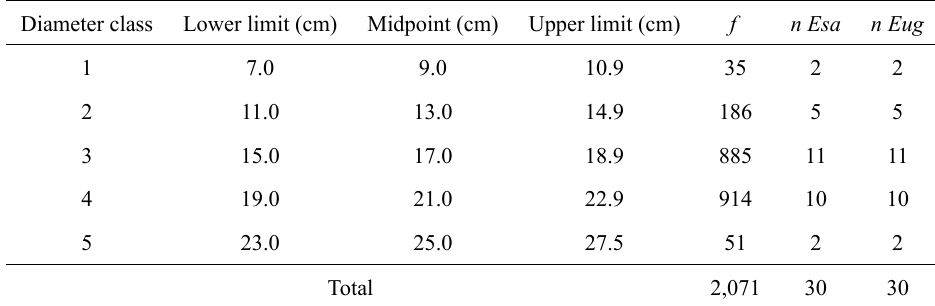
Diameter tree distribution and sampling in E. saligna and E. grandis × E. urophylla stands. Diameter class Lower limit (cm) Midpoint (cm)